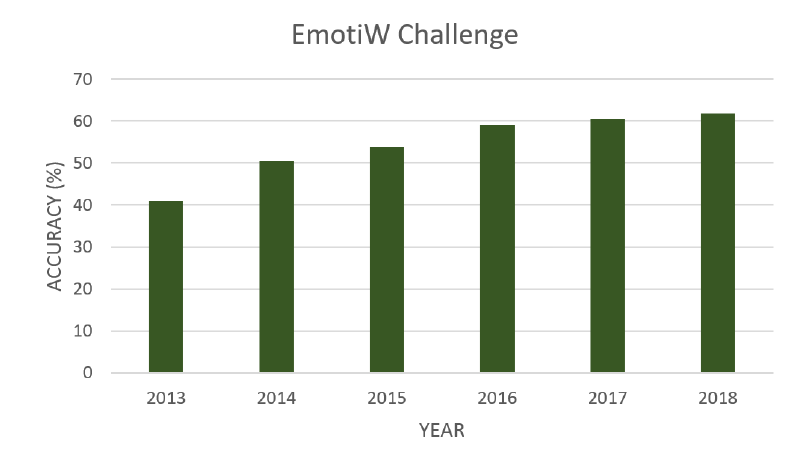
Figure 23. EmotiW challenge winners’ accuracy over